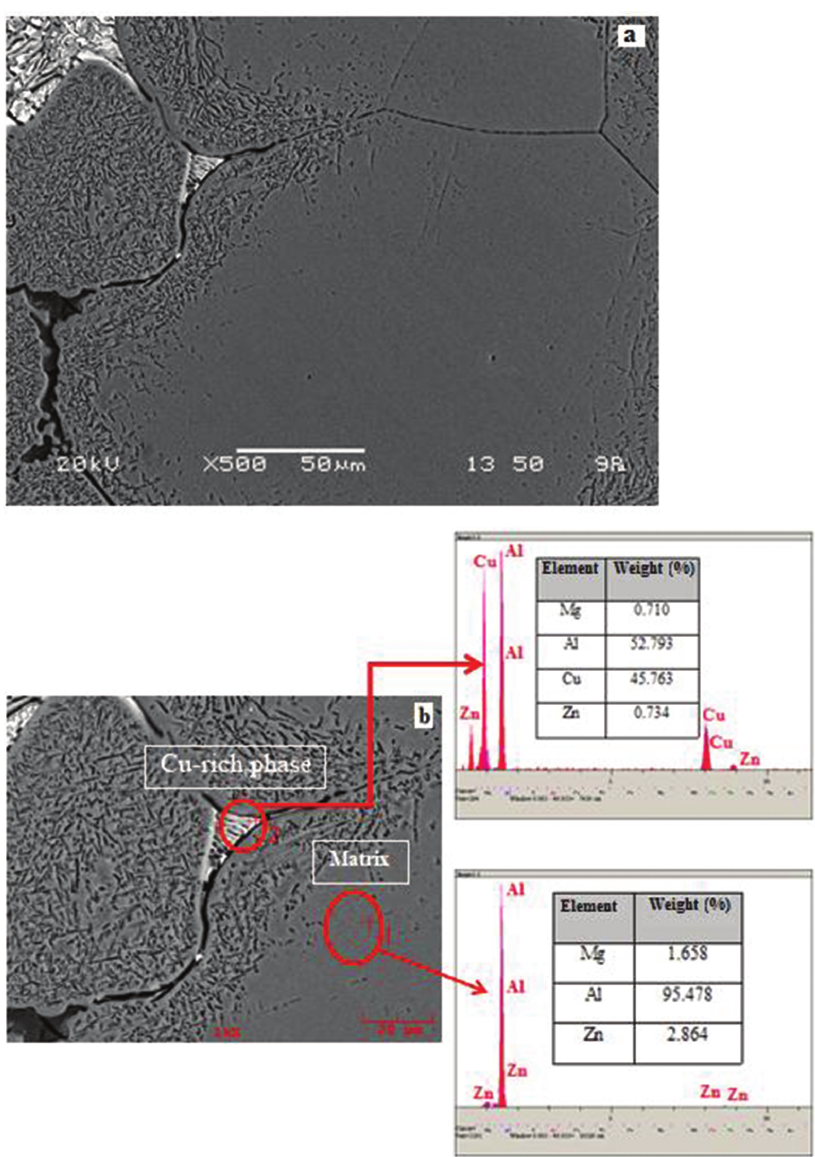
Figure 2: The SEM microstructure of the casting AA7075 (a), EDS graphic